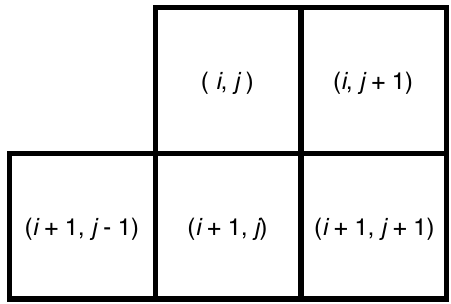
Figure 3. Set of adjacent MSGCN coefficients used to form the joint distribution model. The additional symmetrically placed samples relative to the coordinate ( i , j ) are not included to reduce the model size and since it is likely that distortions along the same orientation will be